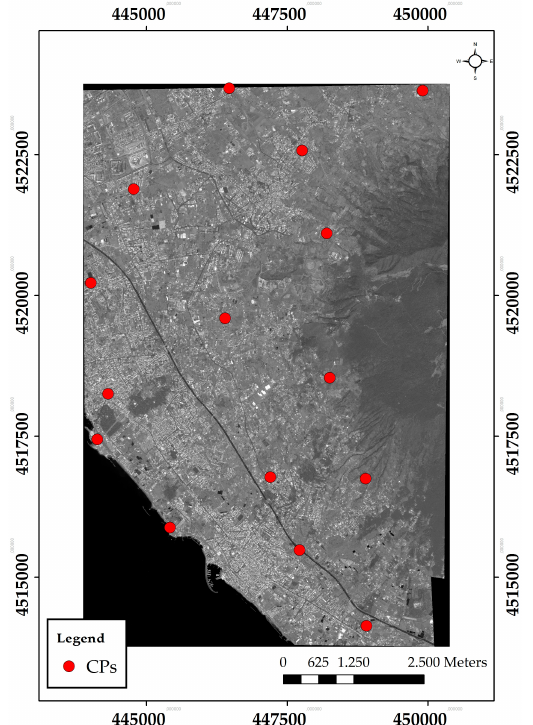
Figure 4. 15 CP distribution in WV-2 primary panchromatic image. The coordinates reported are referred to as UTM/WGS84 (33 N—zone T) and are expressed in meters. Table 1. Residuals (in meters) obtained for CPs in the primary WV-2 panchromatic image. Primary Panchromatic Image Min